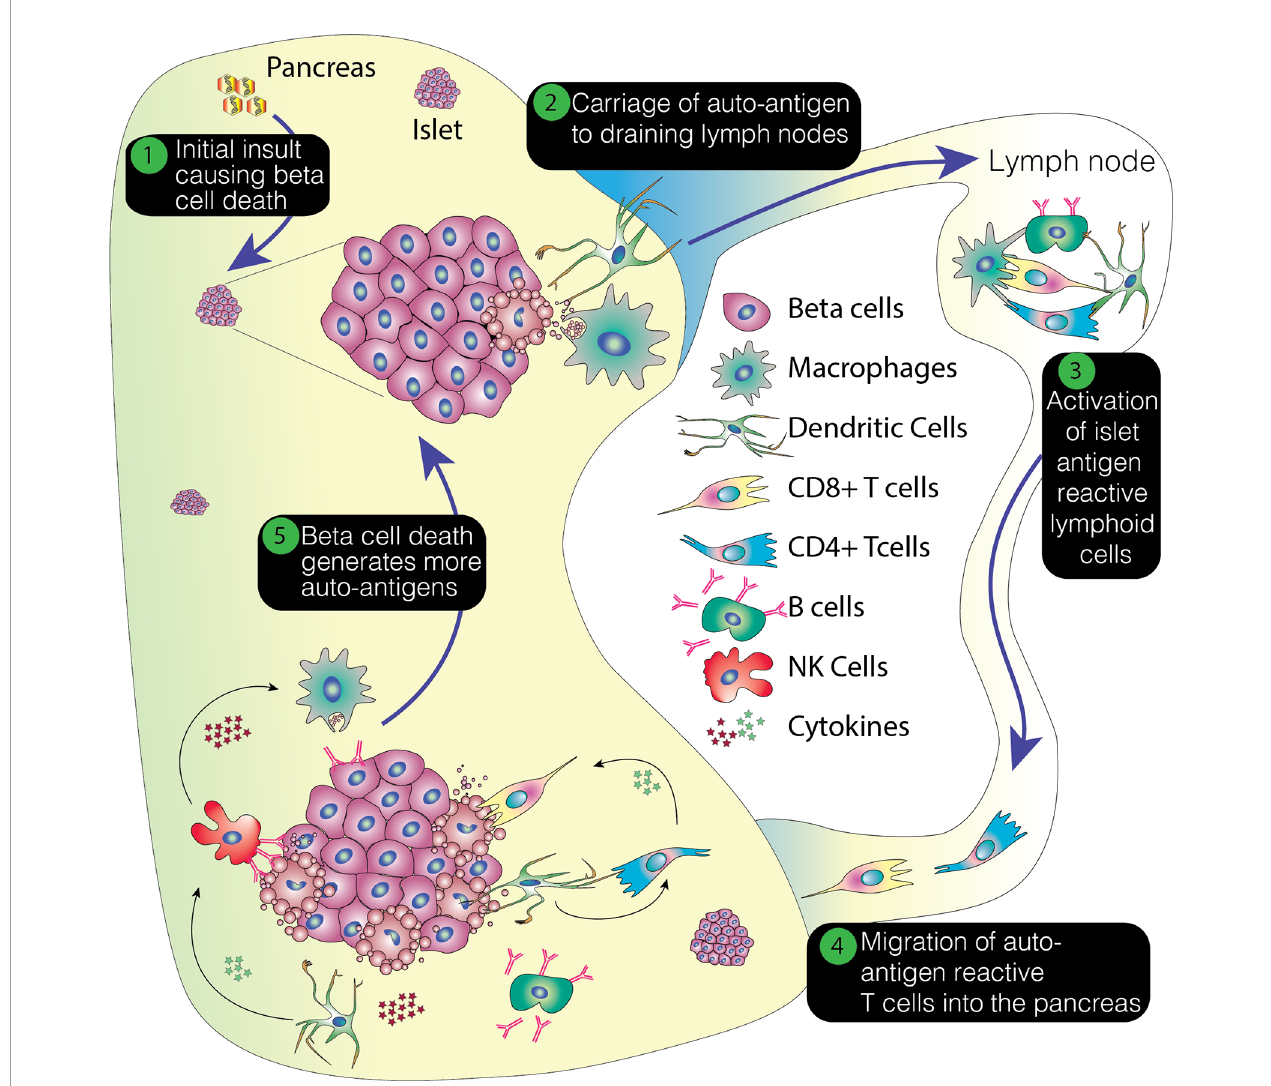
FIGURE 1 | Overview of the pathogenesis of T1D. This process envisages an initial insult that creates beta cell stress or death. The former potentially leading to the production of neoantigens and the latter resulting in the release of beta cell proteins. This damage results in the attraction of immune cells, with emigrant antigen presenting cells picking up and processing the proteins and conveying them to the pancreatic lymph nodes. Here, autoreactive or neoantigen speci fi c T cells are recruited and these then migrate back to the pancreas, potentially promoting further in fl ammation, stress and cell death. This positive feedback loop ultimately results in the loss of beta